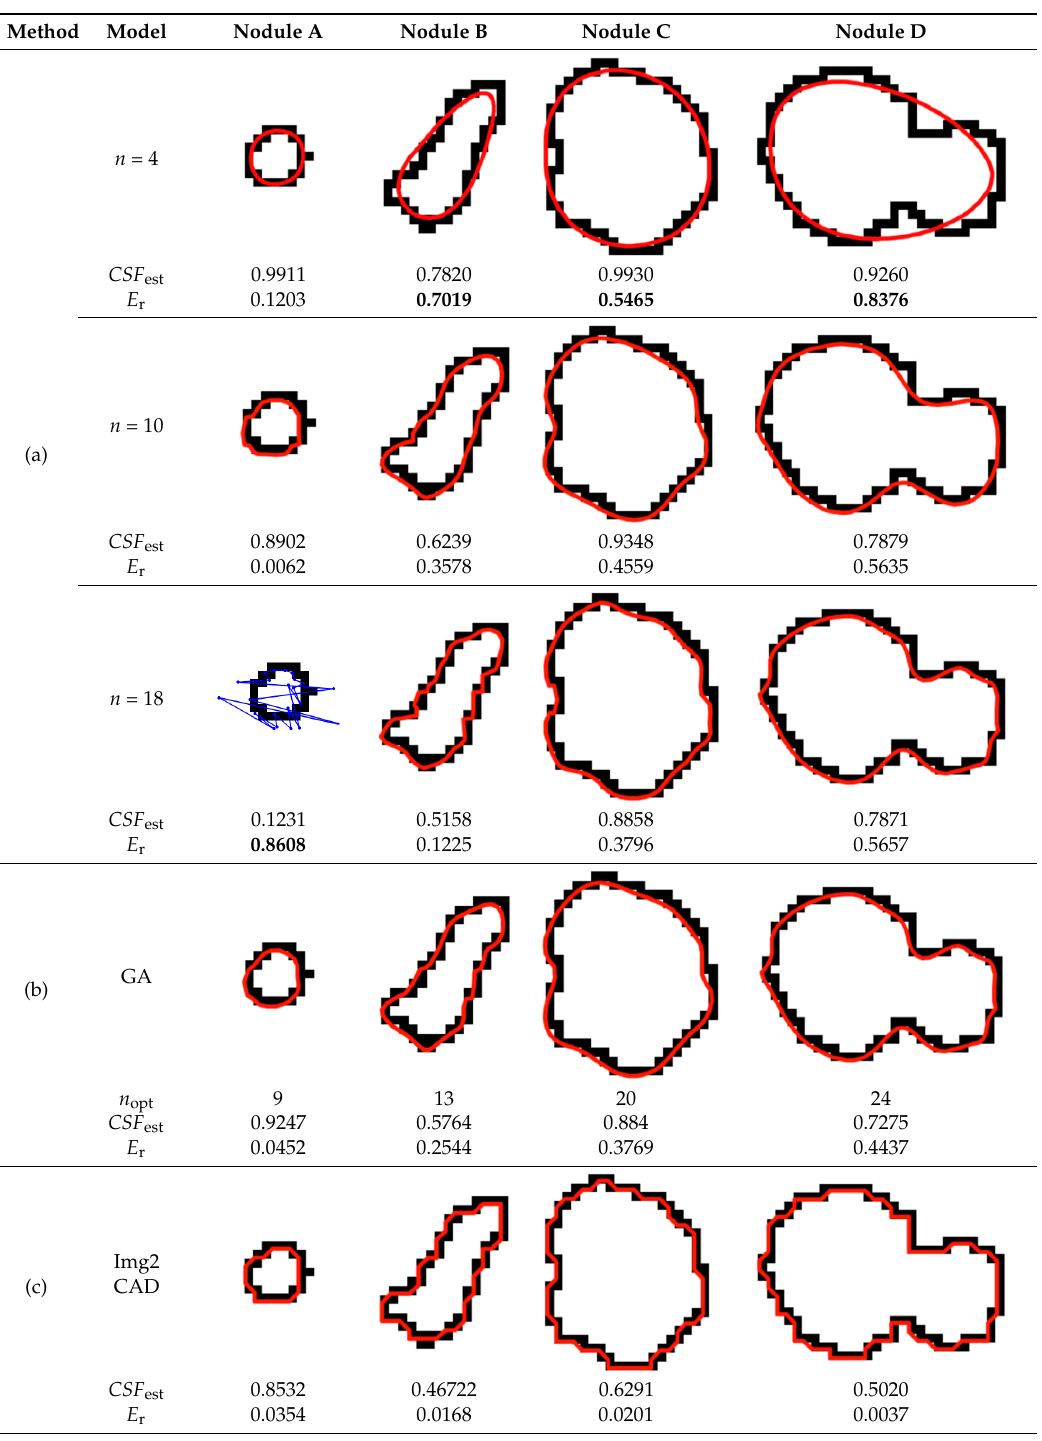
Table 1. Geometric comparison of the obtained models using the three different methods: (a) using a fixed Bézier degree for all the graphite nodules; (b) the proposed methodology; and (c) with a commercial software, img2CAD.